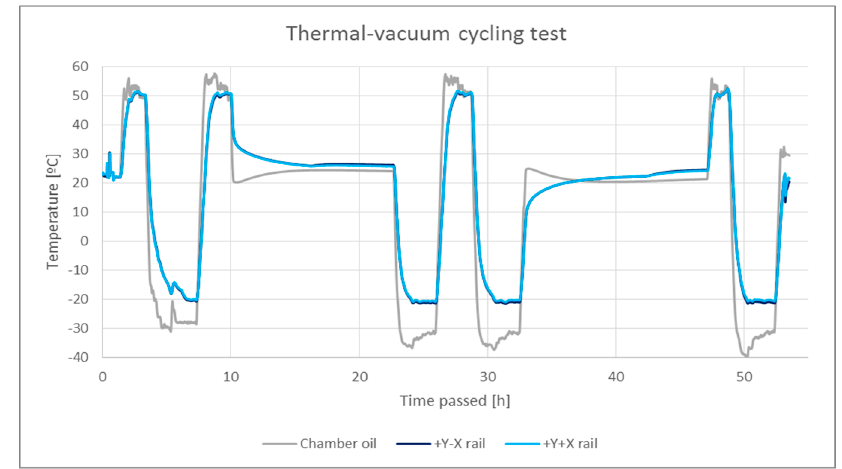
Figure 16. Temperature profile during thermal-cycling test.